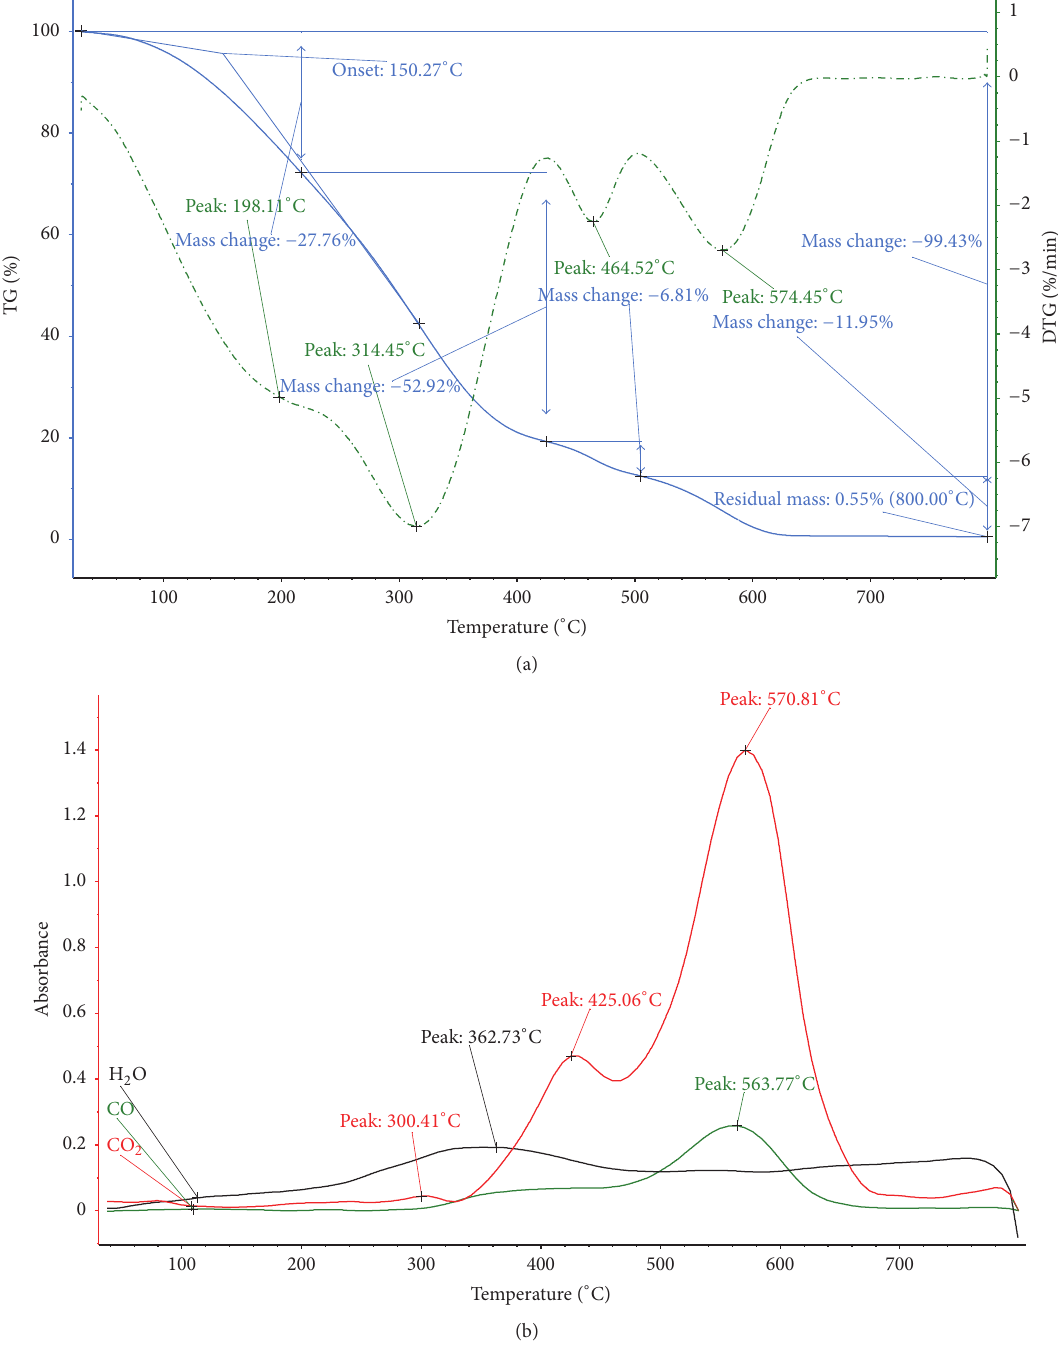
Figure 3: Crude oil oxidation. (a) TG and DTG of oil oxidation and (b) CO, CO 2 , and water output into gaseous phase.